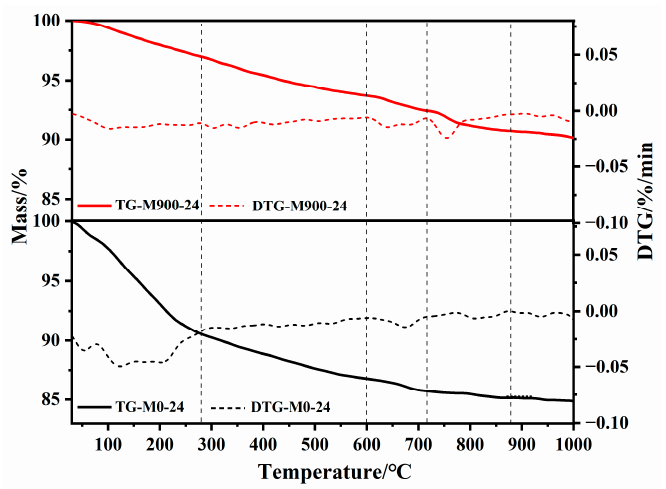
Figure 9. The TG-DTG curves of samples synthesized from hydrated cement (M0) and calcined hy- drated cement (M900) at 220 °C for 24